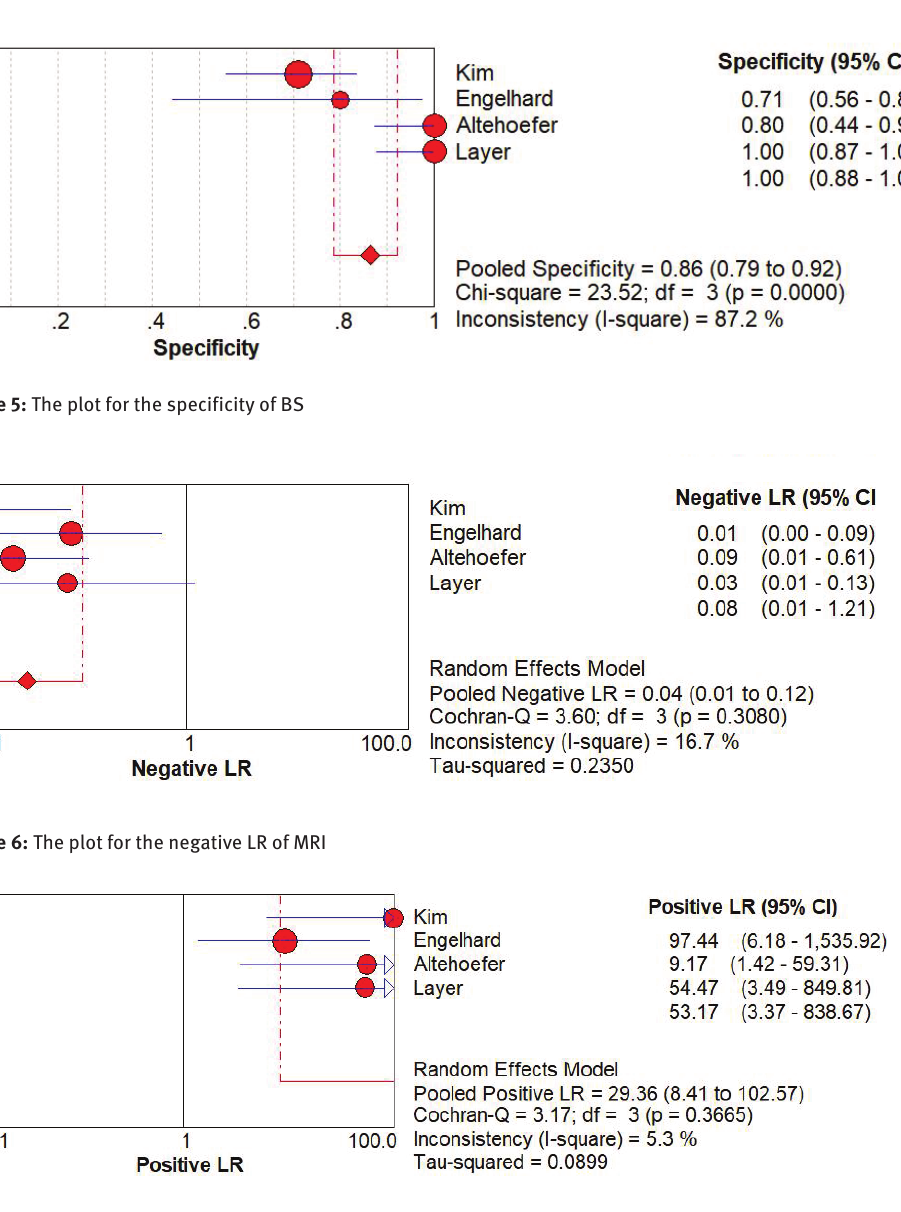
Figure 7: The plot for the positive LR of MRI compared with bone scan, the missed diagnosis rate and misdiagnosis rate of MRI in the diagnosis of breast cancer bone metastasis are very low, and the SROC curve of MRI is close to the upper left corner, that is, the area under the curve is larger, indicating the accuracy of MRI for bone metastasis of breast cancer. Higher, combined with MRI’s method for diagnosing bone metastasis in breast